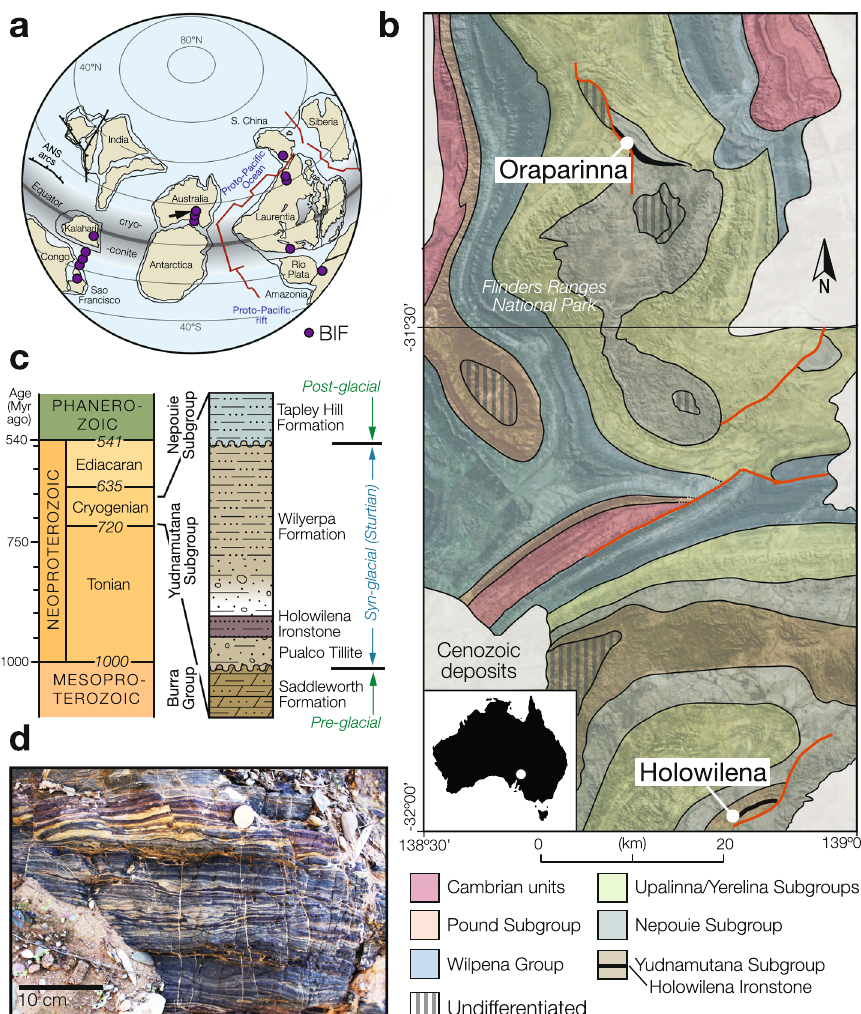
Fig. 1 Spatial and temporal distribution of banded iron formation. a Palaeogeographic reconstruction ca. 700 Myr ago (updated from ref. 44 ) showing the locations of Cryogenian banded iron formation 9 (BIF), and hypothesized cryoconite pans (gray) where cyanobacteria and eukaryotes may have taken refuge during snowball glaciation 12 . b Lithologic map of the two study locations at Oraparinna and Holowilena, South Australia (updated from ref. 21 ). c Simpli fi ed lithostratigraphy of the Sturtian glaciation in the Flinders Ranges, South Australia. d Fine-scale rhythmic banding observed in the Holowilena Ironstone at